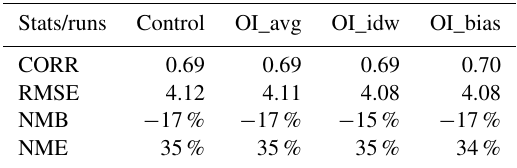
Table 3. Same as Table 2 but for NO 2 .